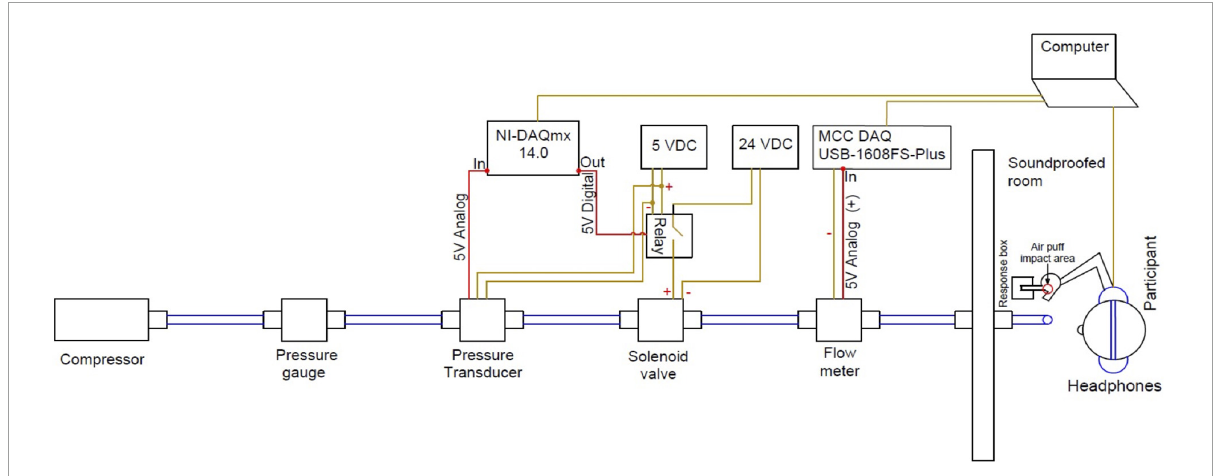
FIGURE2 The aero-tactile stimulus presentation